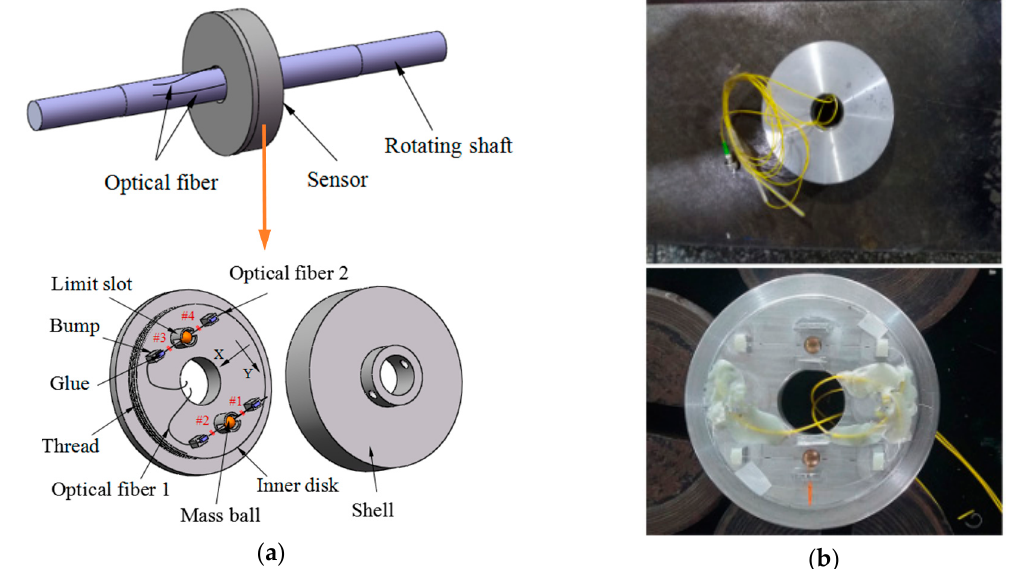
Figure 1. ( a ) The schematic diagram and ( b ) photograph of the proposed rotating mechanical torsional vibration sensor.